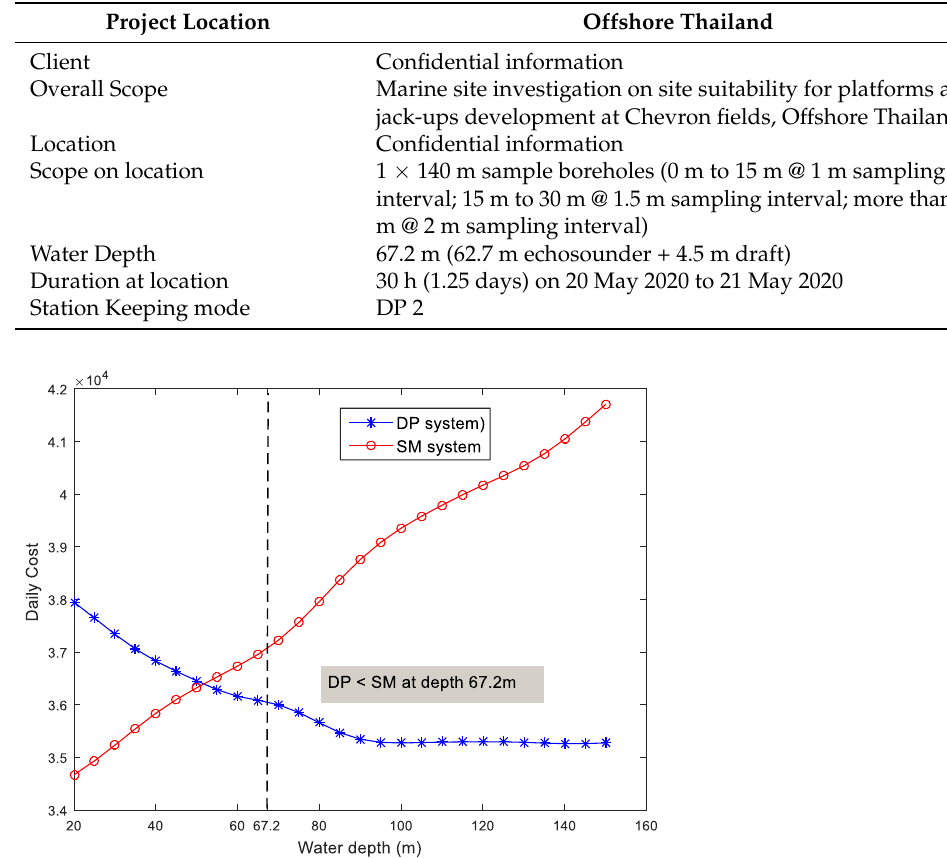
Table 12. Specification for a project undertaken with SM arrangement.